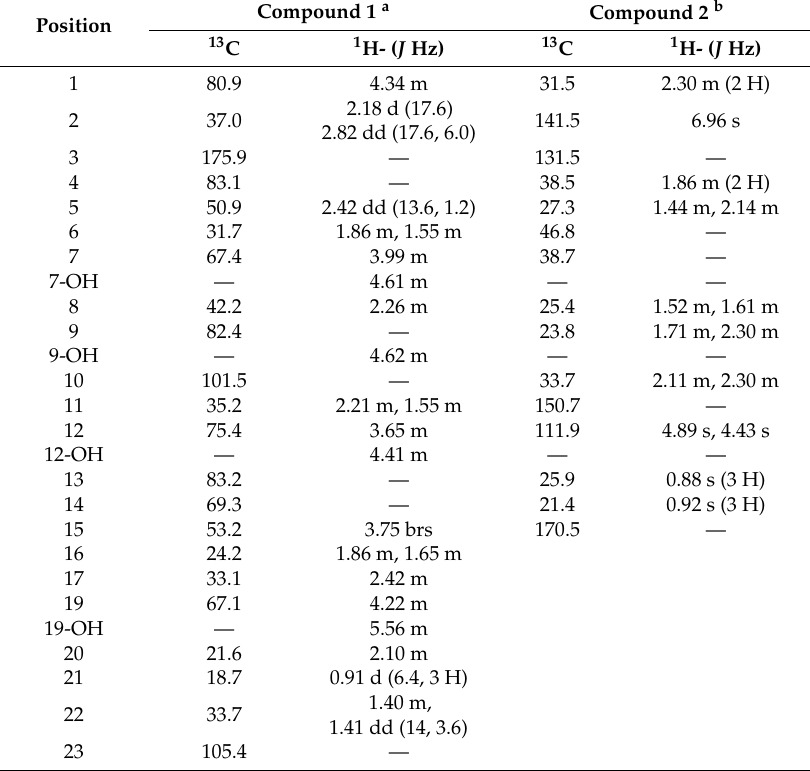
Table 2. 1 H- (600 MHz) and 13 C-NMR (150 MHz) data of 1 and 2 . Compound 1 Position